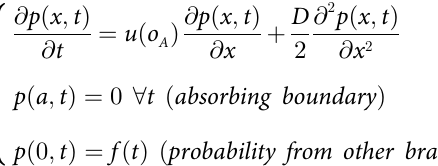
Fig 2. Stochastic representation of the decision process between lotteries L 1 = { o 1 − q }. Branches 1 a − b (resp. 2 c − d ) represent the outcomes of L 1 (resp. L 2 ) and their related probabilities. The difference between the continuous and dashed lines represent the energy potential associated with the constant forces { u ( o A ), u ), u ( o ), u ( o )} exerted on the Brownian particle along each segment {1 ( o B C D the end of each branch depict the absorption boundary conditions. The segment lengths { a , b , c , d } are determined by the objective probabilities { p , 1 − p , q , 1 − q }. The probability of choosing lottery L 1 (resp. L 2 ) is given by the probability of being absorbed along branch 1 a or 1 b (resp. 2 c or 2 d